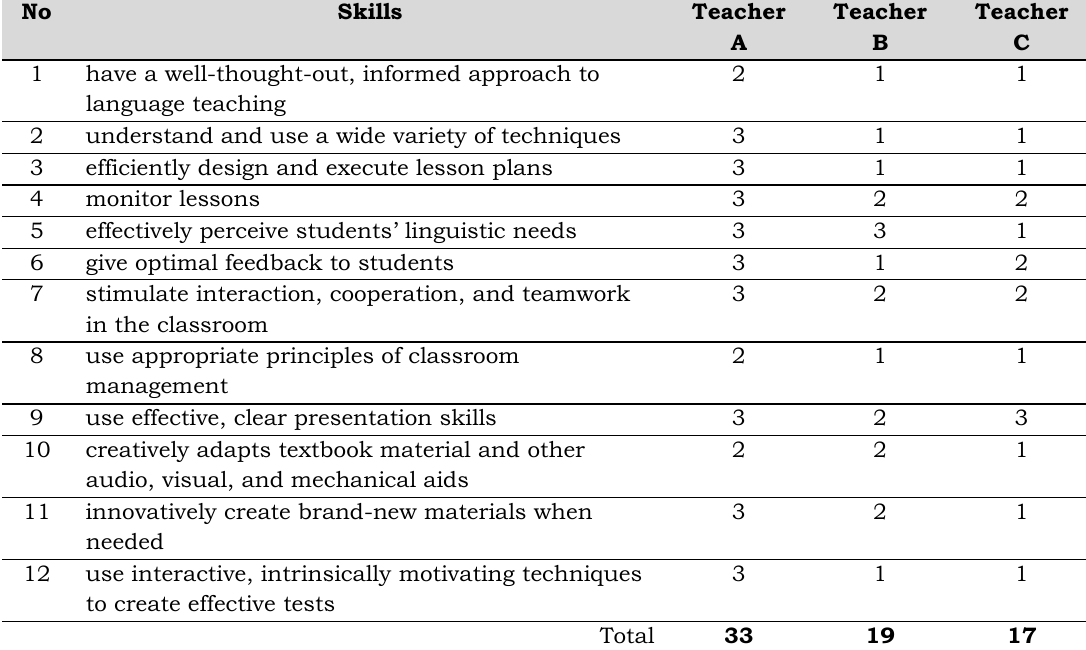
Table 4. Score of initial pedagogical